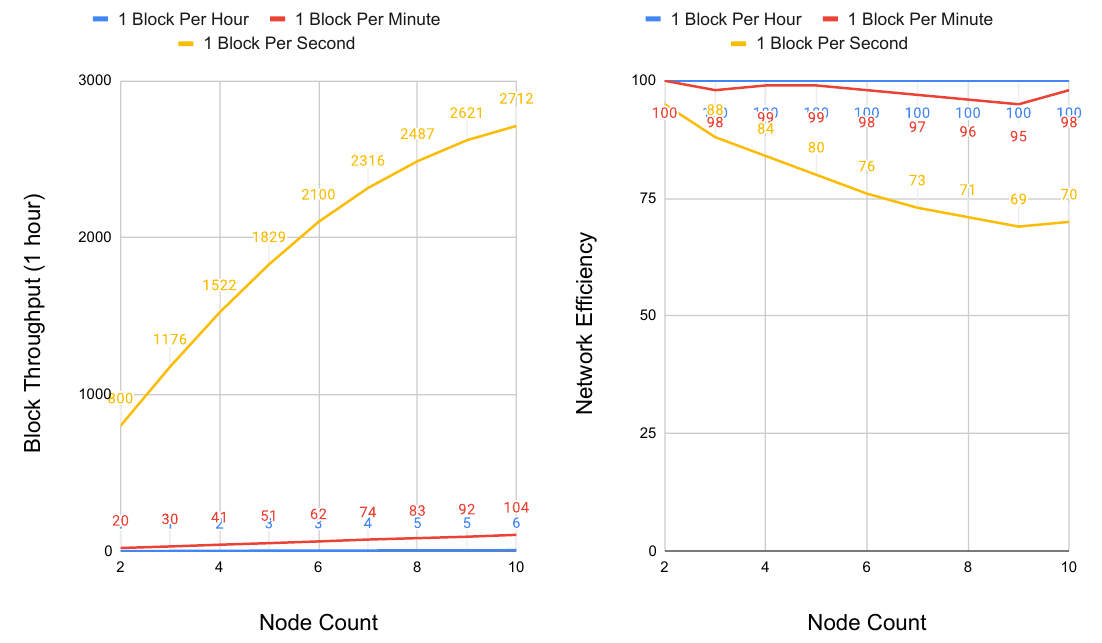
Figure 6. Performance and scalability of Conte at 1500 km node distances and maximum hops to graph edge of 10. Block Throughput ( left ) and Network Efficiency ( right